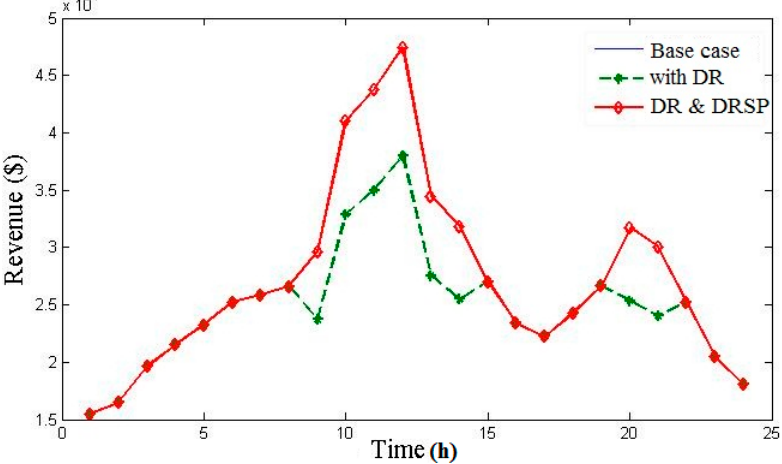
Figure 8. Revenue calculated in TUC, TUC using DR and DRUC.